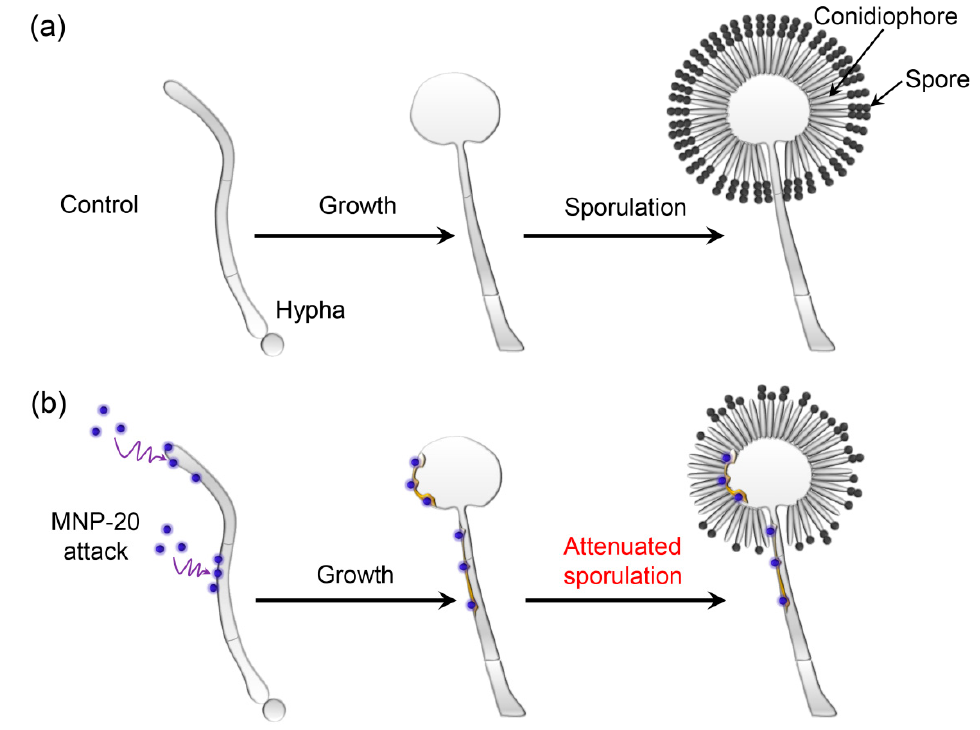
Figure 6. Schematic illustration of attenuated sporulation of A. niger induced by MNP20. ( a ) Normal growth and sporulation of the A. niger hyphae on the conidiophores in the control group without MNP treatment. ( b ) Normal growth but attenuated sporulation in the MNP20-treated hypha. The attack of MNP20 led to partial cell wall damage, leading to attenuated sporulation on the conidiophores.